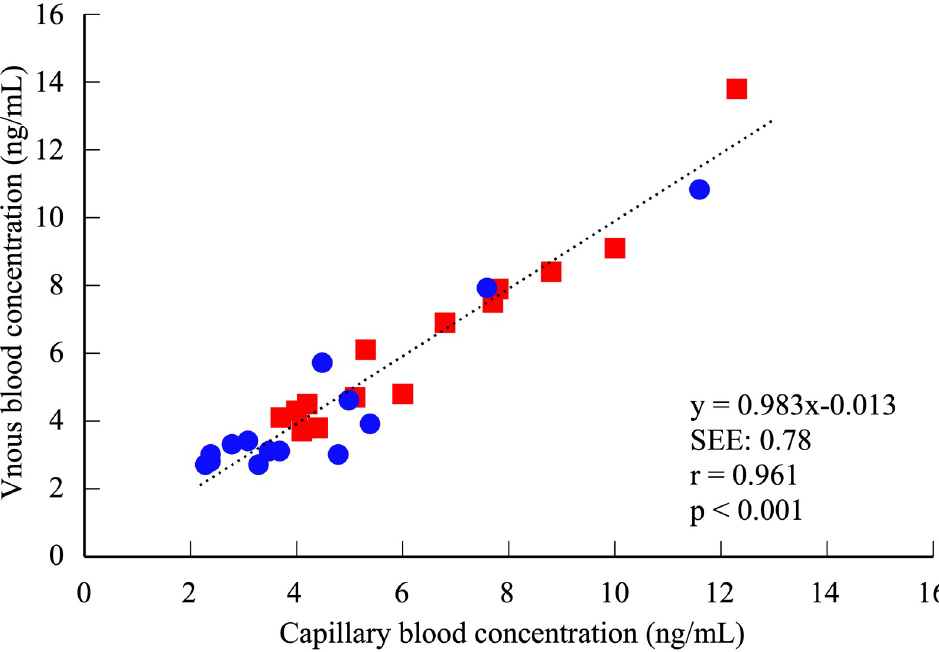
Fig 2. Correlation of plasma FABP4 concentration between venous and capillary blood. Circle and triangle plots represent males and females, respectively. Pearson’s correlation coefficients, All participants: r = 0.962 ( p < 0.001), males: r = 0.945 ( p < 0.001), females: r = 0.970 ( p < 0.001).